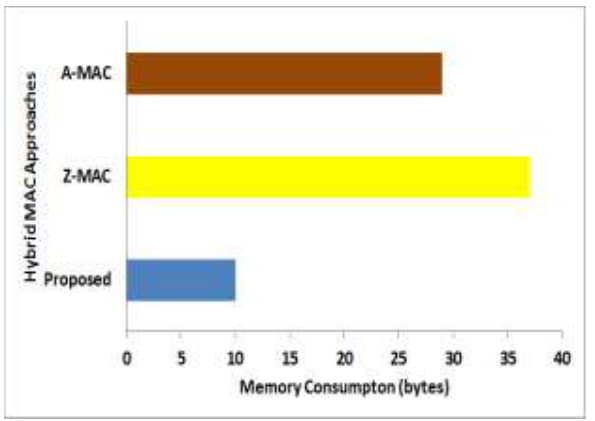
Figure 5. Comparative Analysis of memory